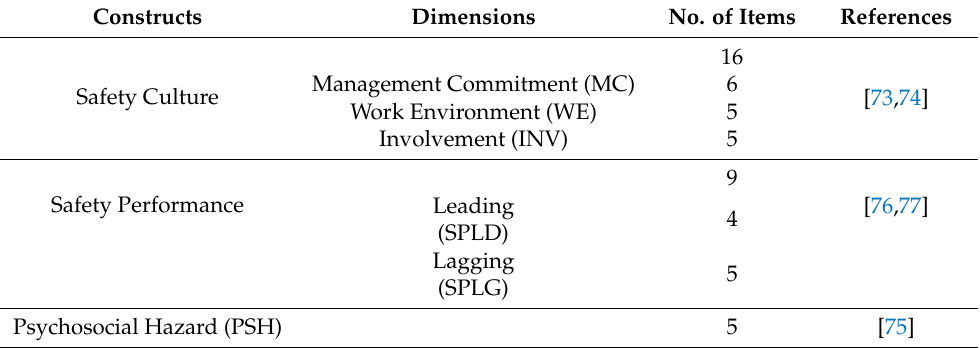
Table 3. Study instrument